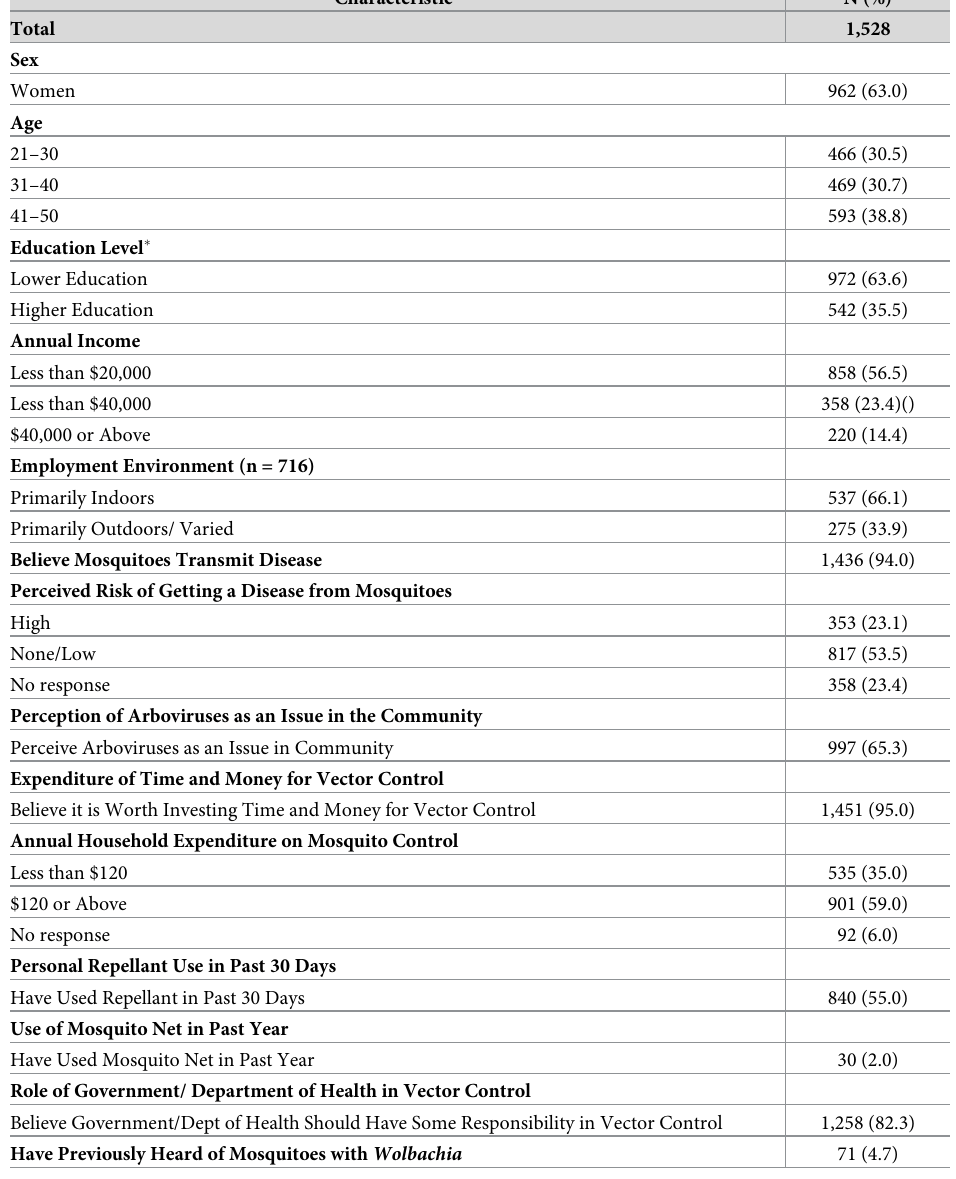
Table 1. Characteristics of study participants responding to the Vector Control Interventions survey, COPA, Ponce, Puerto Rico 2018–2019.